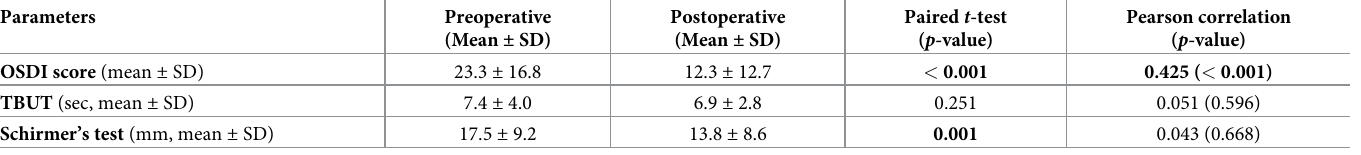
OSDI, ocular surface disease index; TBUT, tear film break-up time Boldface values indicate statistically significant differences at p <